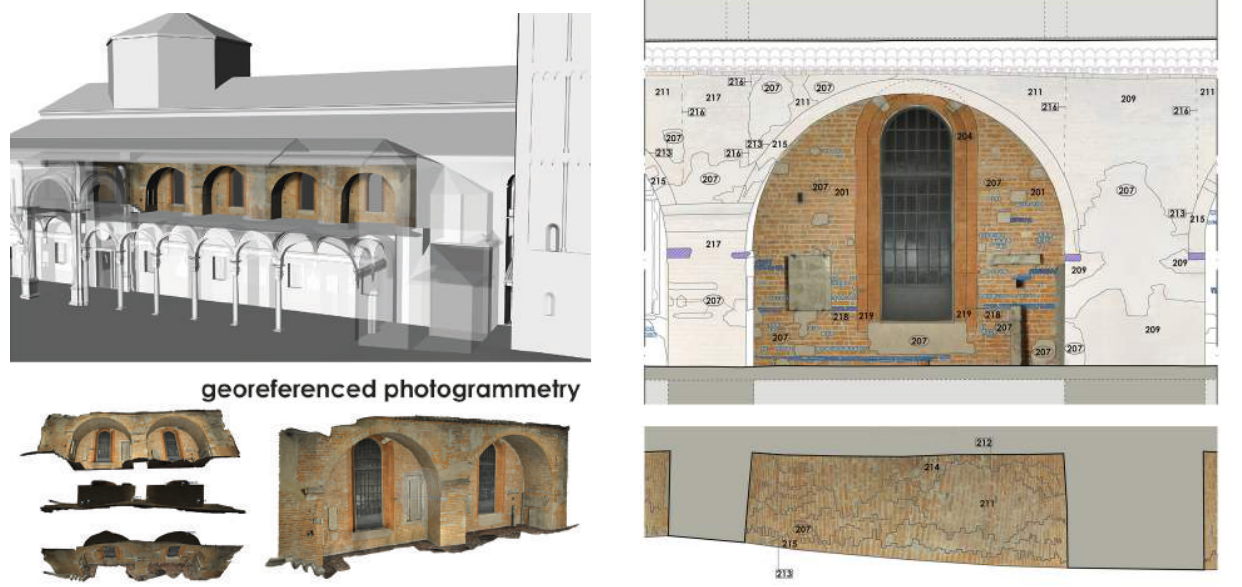
Figure 7. Example of stratigraphic